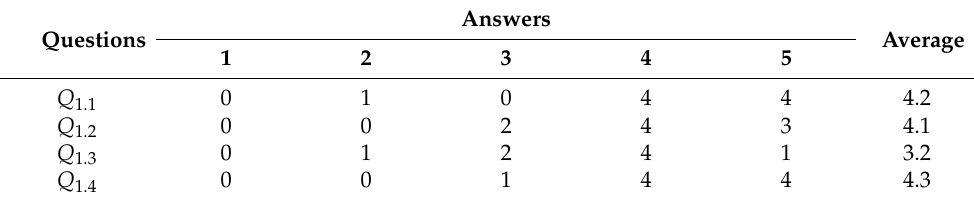
Table 1. Questions and answers to evaluate Video quality.